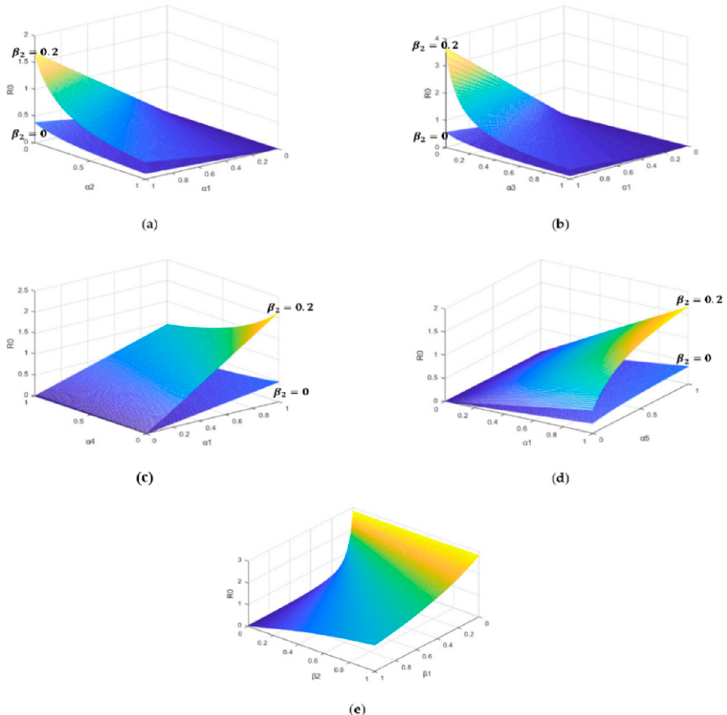
Figure 1. Mutual influence of parameters. ( a ) The relationships between α 1 , α 2 , and R 0 . ( b ) The relationships between α 1 , α 3 , and R 0 . ( c ) The relationships between α 1 , α 4 , and R 0 . ( d ) The relationships between α 1 , α 5 , and R 0 . ( e ) The relationships between β 1 , β 2 , and R 0